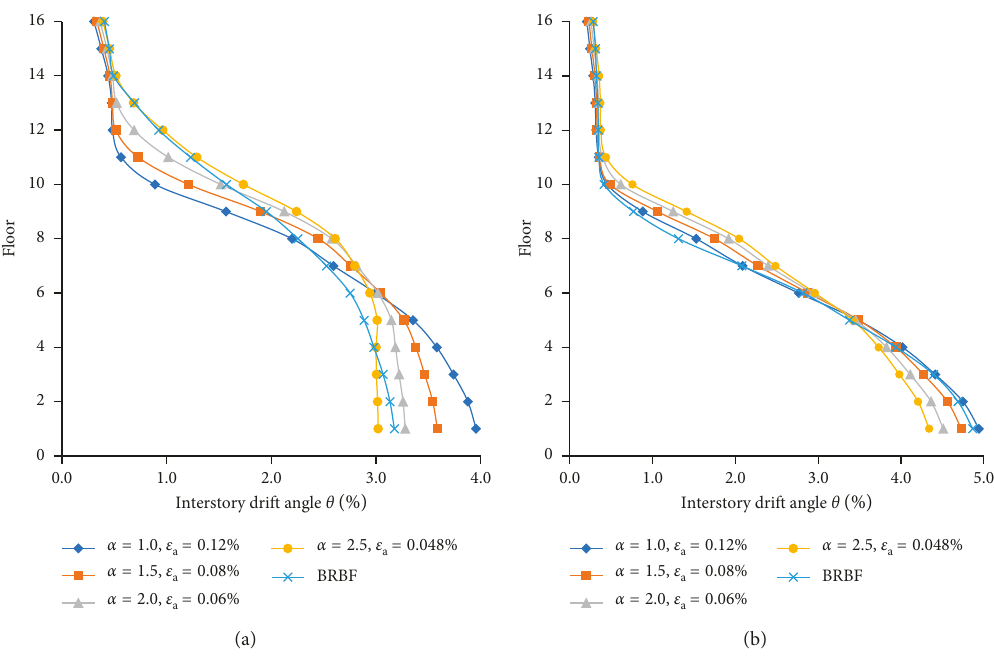
Figure 27: The effects of ε and α on the interstory drifts of 16-story SC-TOBFs: (a) LD-1 and (b) a